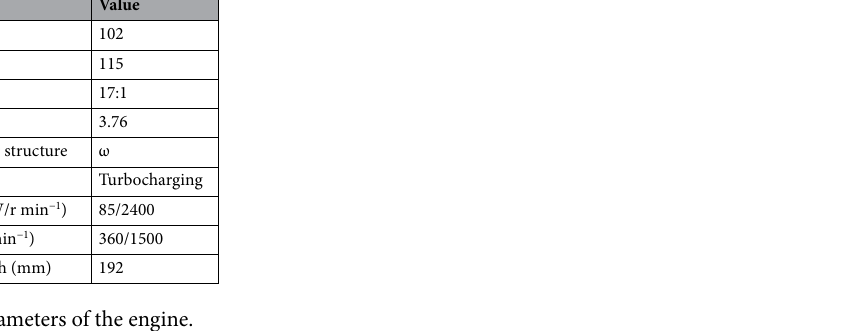
Table 1. Key parameters of the